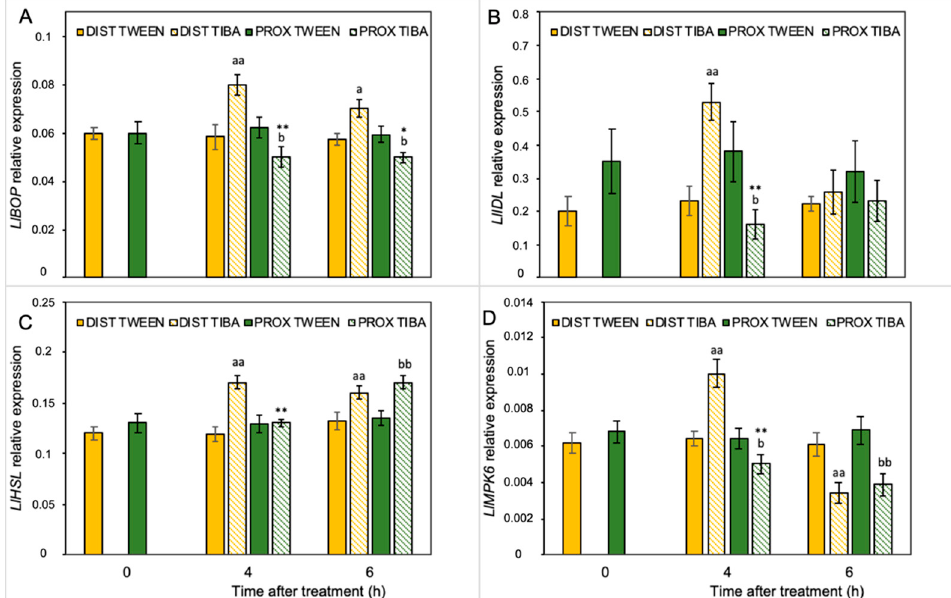
Figure 3. Different parts of the AZ treated with polar auxin transport inhibitor were characterized by a specific pattern of expression of abscission-related genes. The relative transcript levels of LlBOP ( blade-on-petiole ) ( A ), LlIDL ( inflorescence deficient in abscission ) ( B ), LlHSL ( HAESA-like ) ( C ), and LlMPK6 ( mitogen-activated protein kinase 6 ) ( D ) were investigated. A solution of 2,3,5-triiodobenzoic acid (TIBA, 0.05 mM in 0.05% Tween 20) or 0.05% Tween 20 solution was applied directly on the inactive flower abscission zone (AZ). Then, the tissue sections containing the AZ ( ≈ 1 mm below and ≈ 1 mm above) were dissected 4 h or 6 h after treatments and divided into a proximal (PROX) and a distal (DIST) part for further RNA isolation. Gene expression was examined using qPCR analysis. LlACT ( actin ) was used as an internal control for the normalization of gene expression. Values are presented as the mean of three biological replicates. Error bars indicate SEs. t -test: ** p < 0.01 and * p < 0.05, proximal versus distal part in the Tween 20-treated AZ for different times after application; aa p < 0.01 and a p < 0.05, TIBA-treated distal part versus Tween 20-treated distal part for different times after application; bb p < 0.01 and b p < 0.05, TIBA-treated proximal part versus Tween 20-treated proximal part for different times after application.